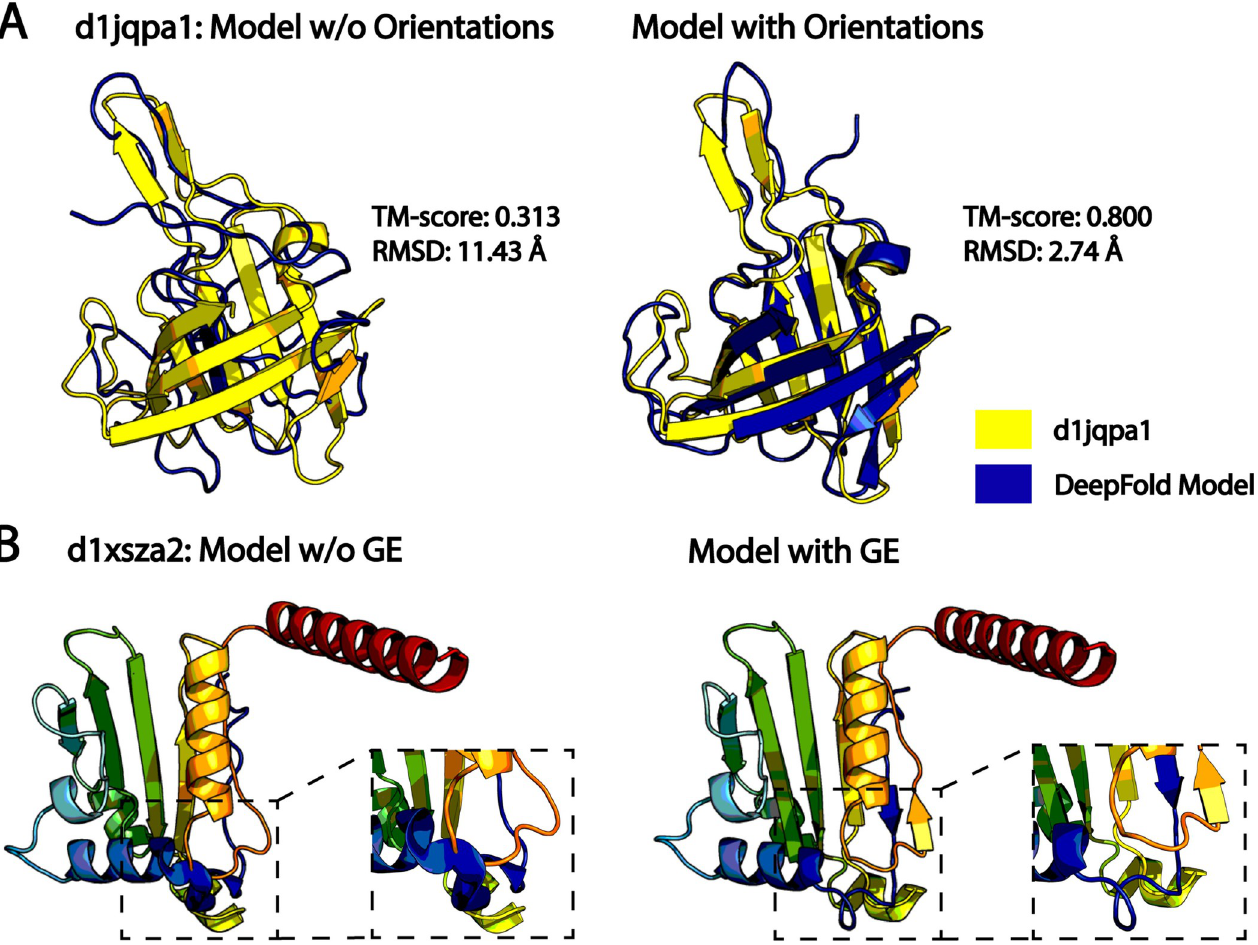
Fig 3. Illustrative folding examples from DeepFold. A) Case study from SCOPe protein d1jqpa1 that demonstrates the importance of inter-residue orientations for folding β -proteins, where the native structure is shown in yellow, and the superposed predicted models built without (left) and with (right) orientation restraints are shown in blue. B) Case study from SCOPe protein d1xsza2, which highlights the importance of the general energy function for improving the physical quality of the models. The models built without (left) and with (right) the general physical energy function are depicted in rainbow coloring, where the clashing region is shown in the inset on the left and the clashes have been resolved in the model built with the general energy function on the right.